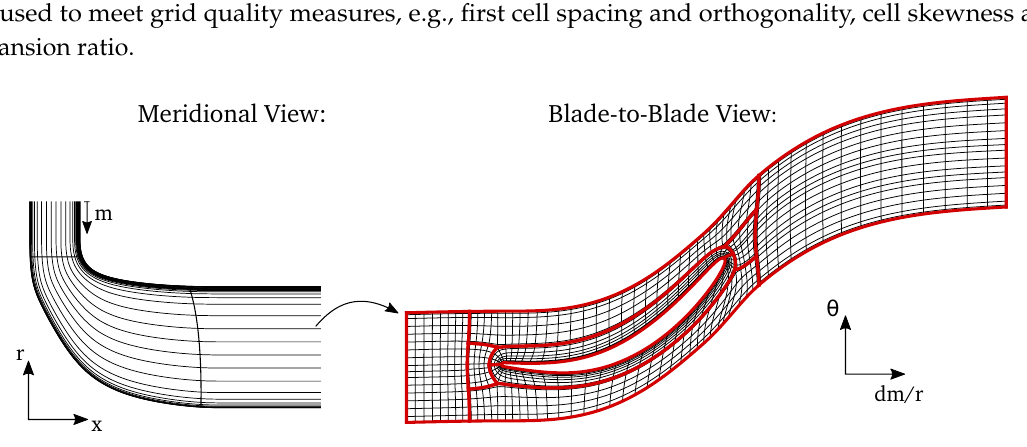
Figure 6. Schematic diagram of the grid generation process. Meridional grid lines ( left ) and blade-to-blade mesh in conformal plane ( right ). Mesh is coarsened for visualization purposes.